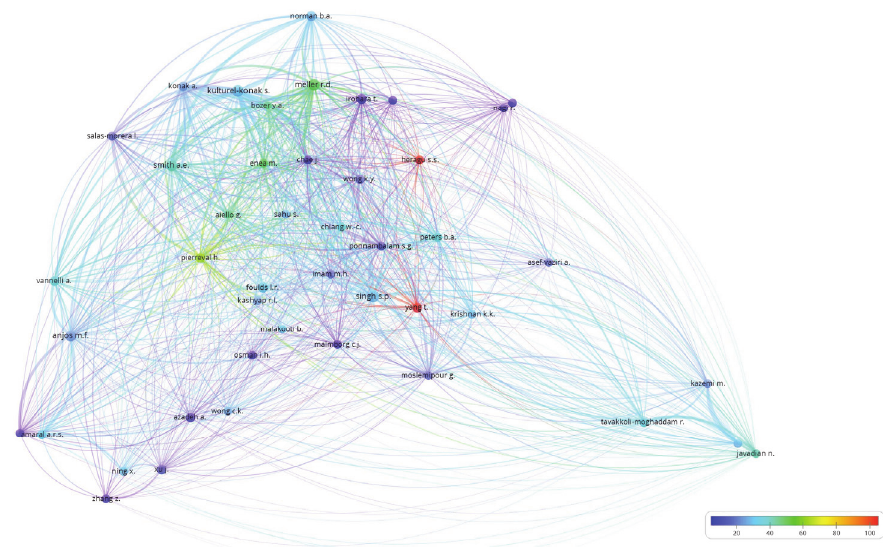
Fig. 5. Citations